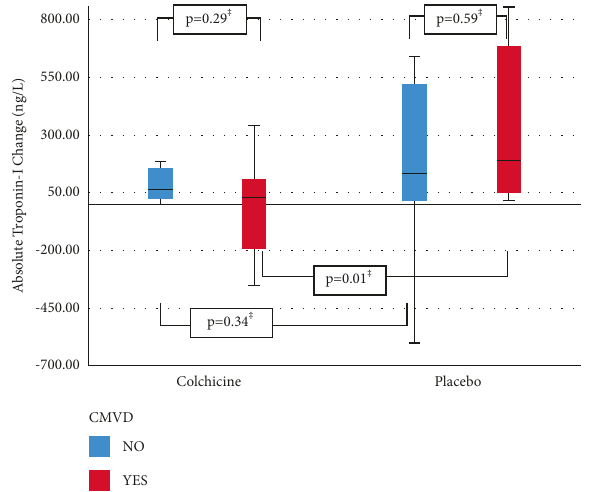
Figure 2: Boxplot of absolute hs-Troponin-I change in patients with or without post-PCI CMVD, according to study drug